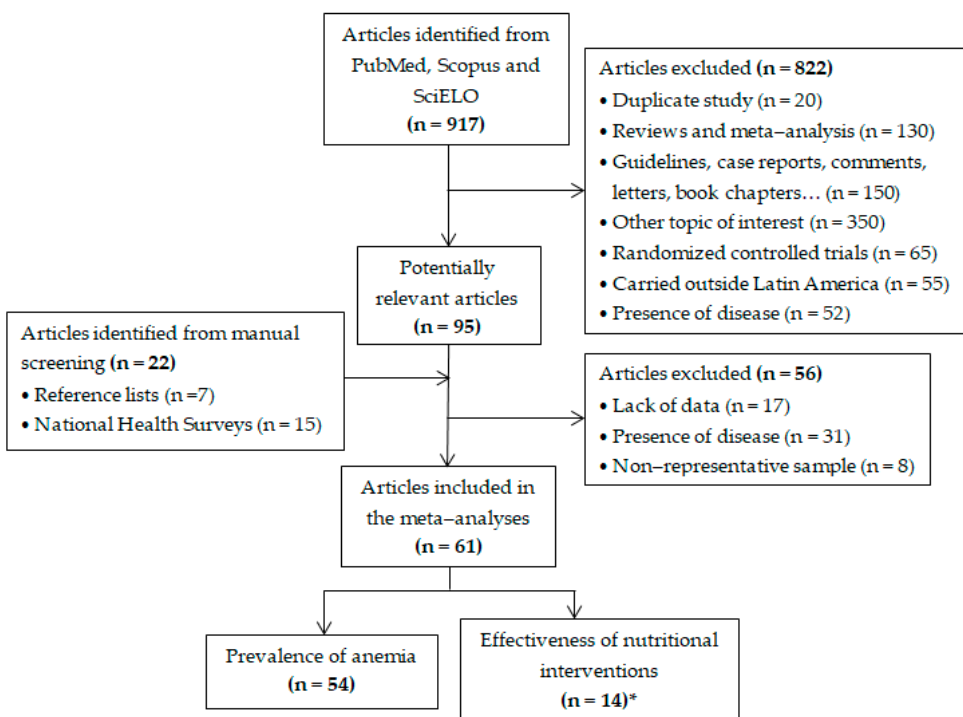
Figure 1. Flowchart of study selection. * This section includes seven new studies that were not present in the meta-analyses of prevalence of anemia.